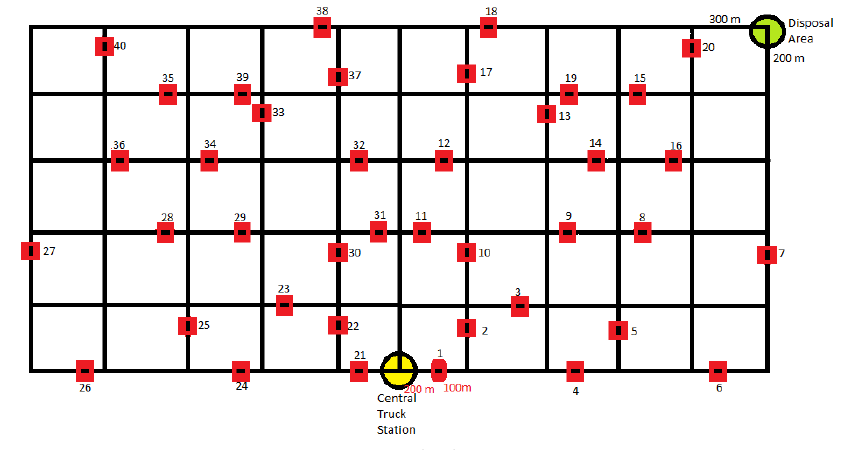
Figure 7. Bin deployment